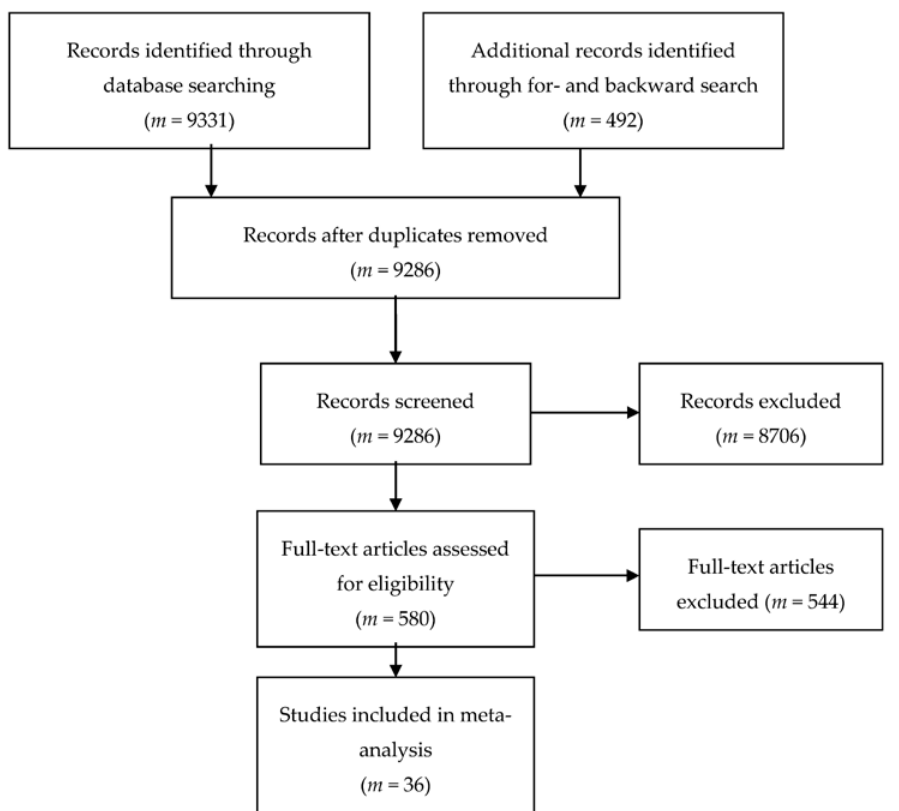
Figure 1. Flow chart of the literature search and study selection process according to Moher, Liberati, Tetzlaff and Altman (2009) [89].